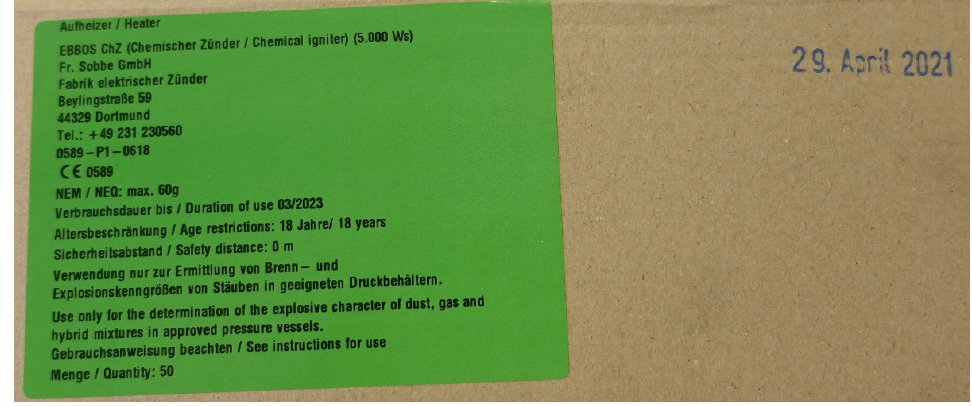
Figure 5. Sobbe igniter label.